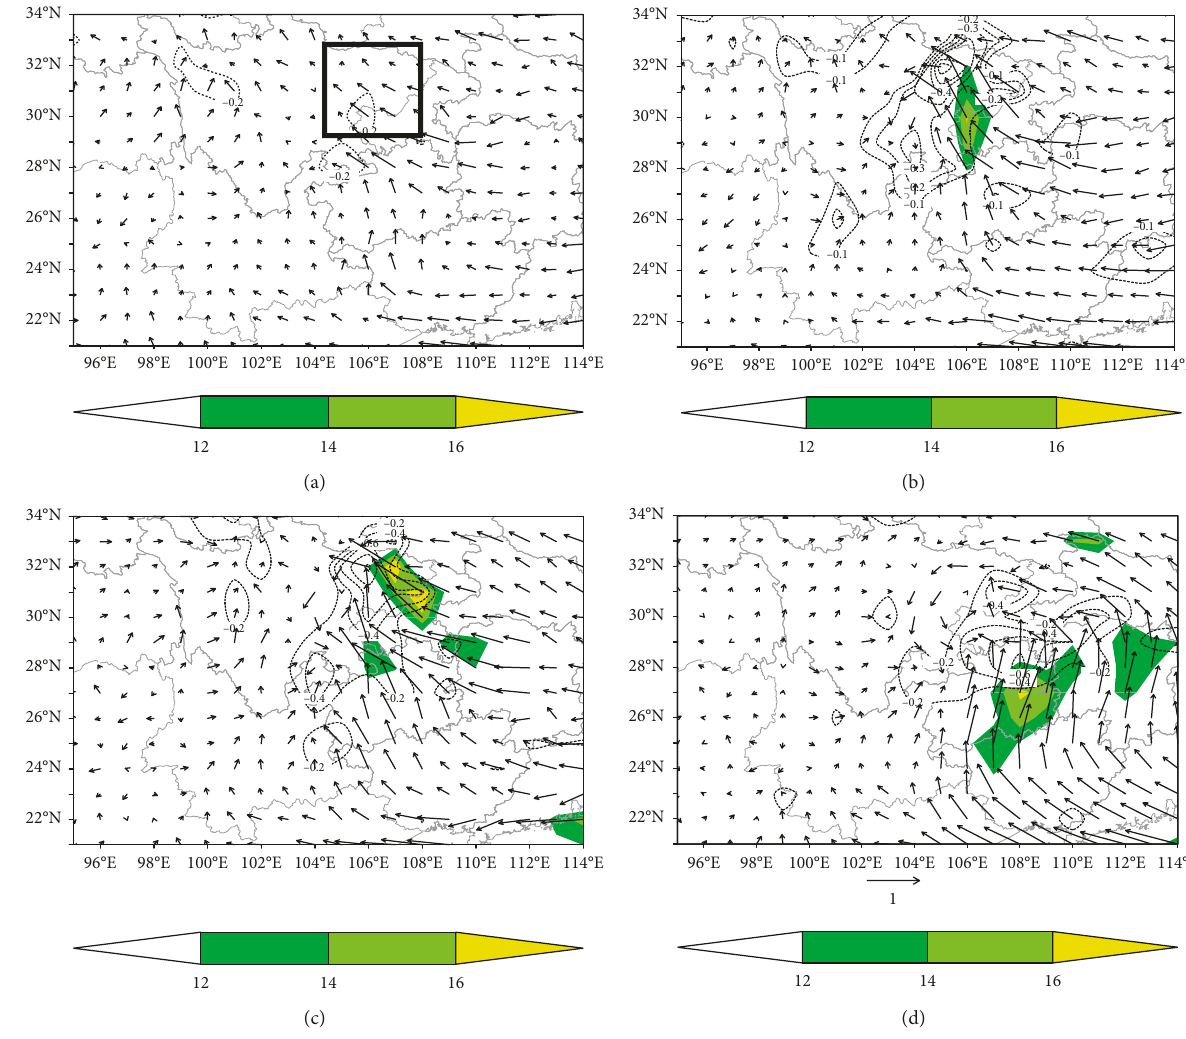
Figure 12: 850hPa water vapor flux vector (arrows, kg